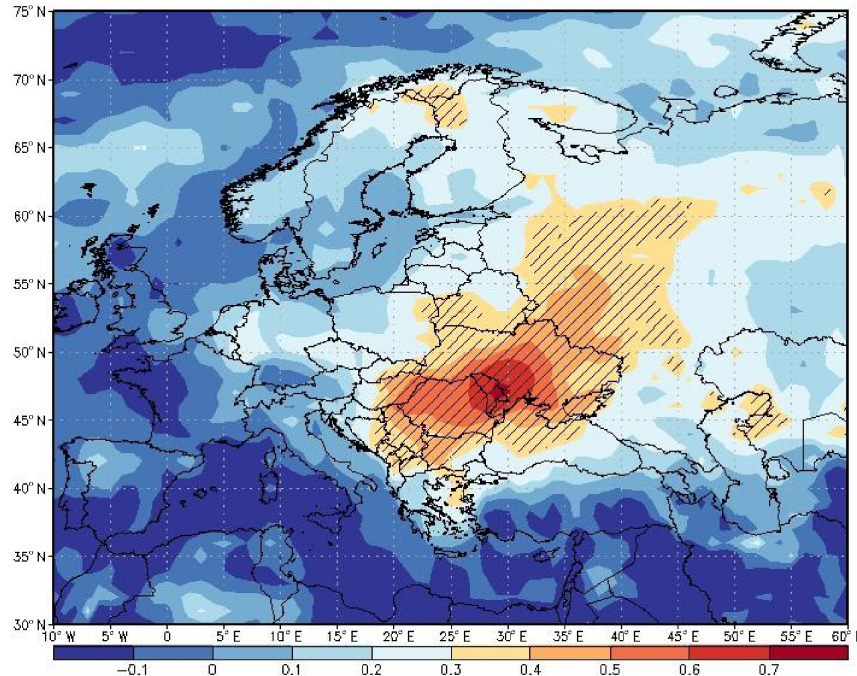
Figure 13. Correlation coefficients between the monthly number of convective storm in the Prut River basin and monthly means of convective available potential energy (CAPE) for the active season (May to August) in the period 2003–2017. The CAPE data are from the ERA 5 reanalysis (the deterministic dataset). Hatched areas illustrate correlation coefficients statistically significant at confidence levels higher than